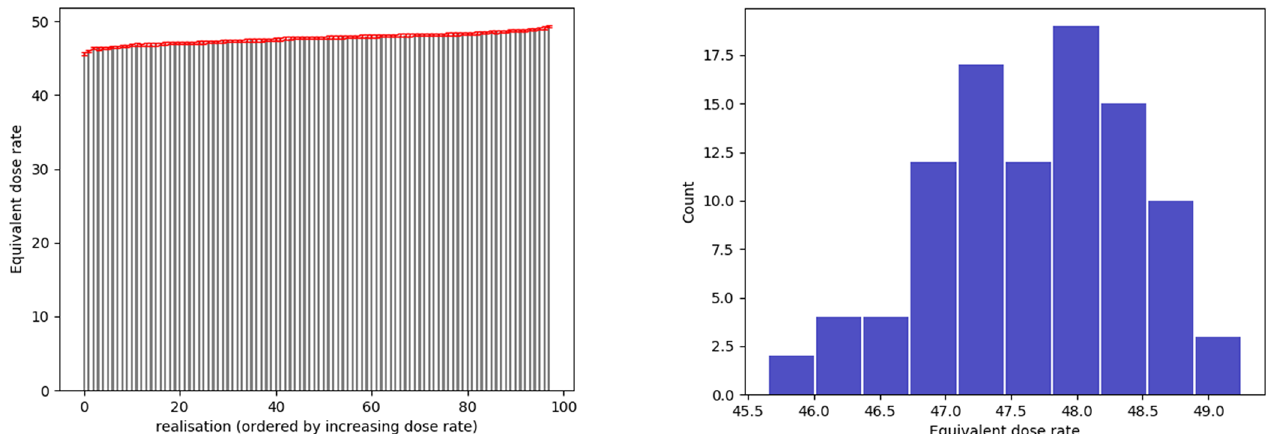
Fig. 10. 100 realizations of spherical inclusions with R = 0.05cm, j =0.00121 and r MOX =6.6 g/cm 3 (left: realizations ordered by dose rate, with 2-sigma error bars in red and right: histogram).